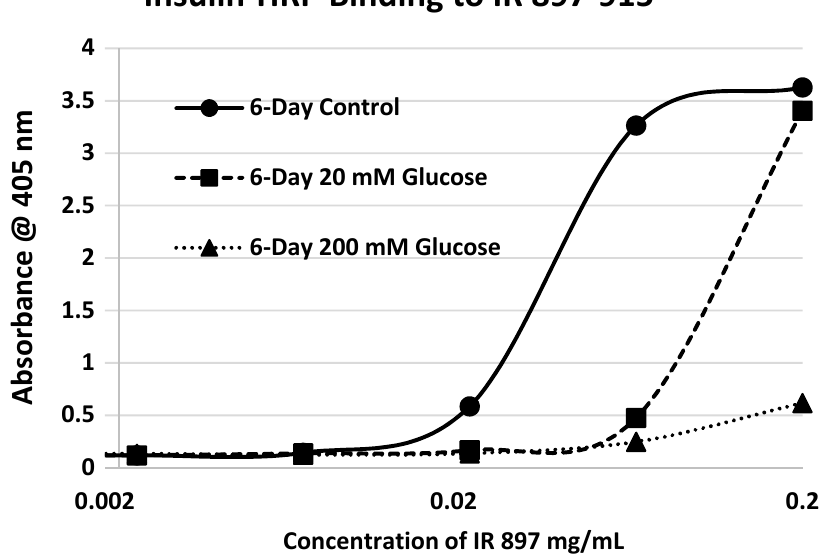
Figure 9. Insulin – HRP binding to insulin receptor (IR) 105 – 118 in the absence and presence of glucose over six days.